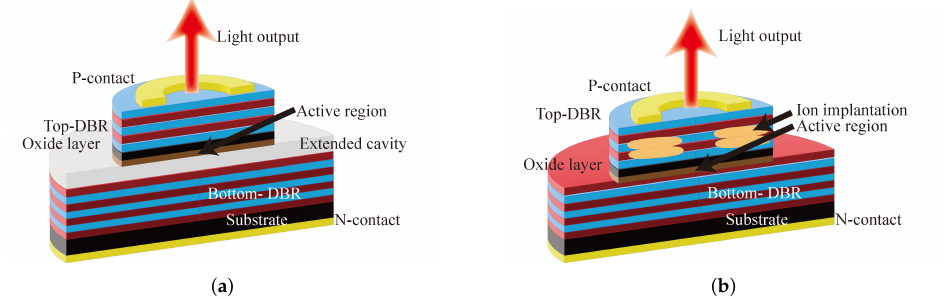
Figure 4. Structure of the different methods for realizing single-mode outputs ( a ) Extended cavity VCSEL; ( b ) ion implantation